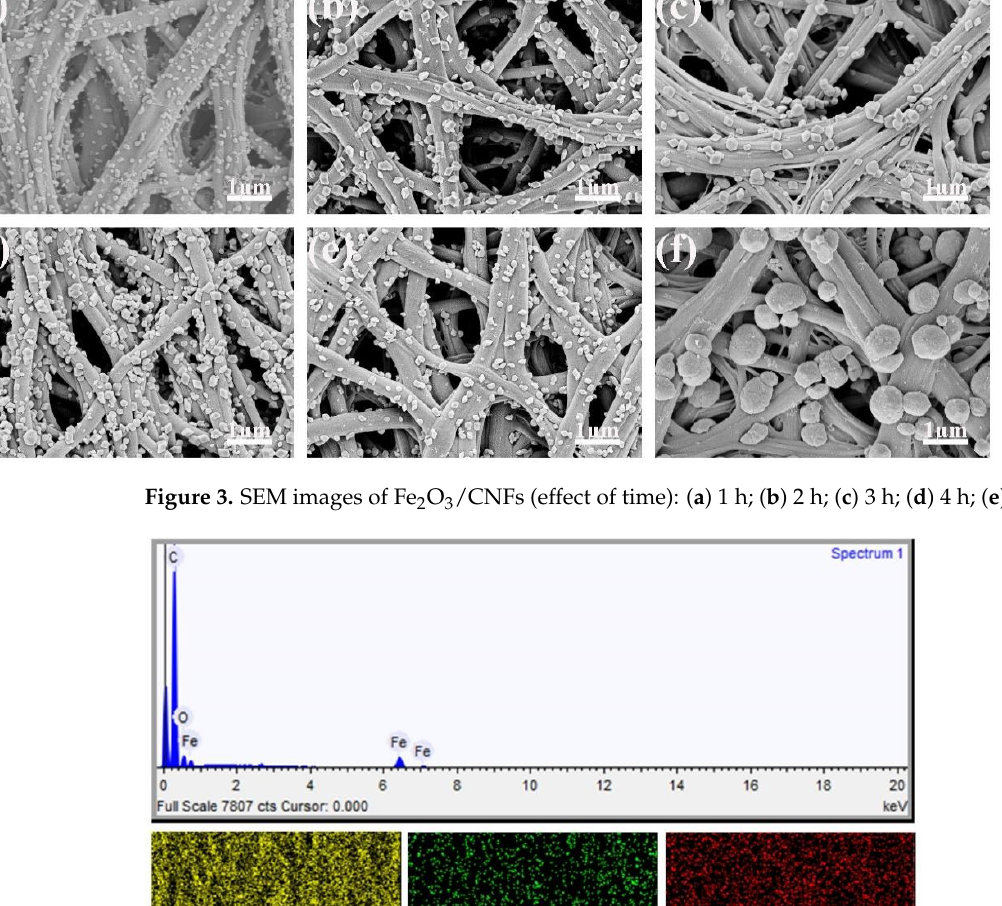
Figure 4. EDS image of Fe 2 O 3 /CNFs.